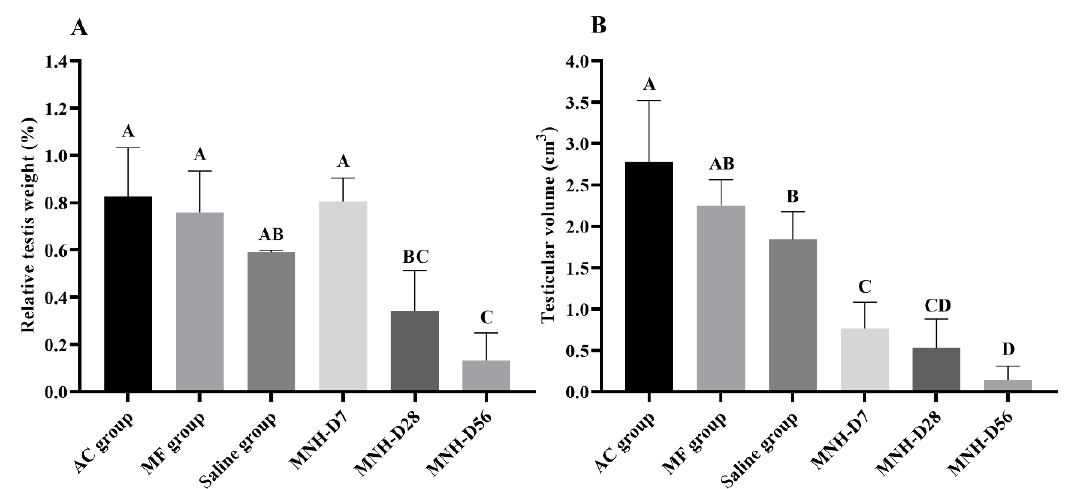
Figure 5. ( A ) Mean ( ± SD) relative testis weight (%) and ( B ) Mean ( ± SD) testicular volume (cm 3 ) for each experimental group on the day of euthanasia. (ABC—different letters indicate significant difference, p < 0.05.) AC Group animal testicles were exposed to the external AC magnetic field only. MF Group animals received an intratesticular injection of the magnetic fluid only. Saline Group animals received an intratesticular injection of sterile saline solution. MNH Group animals received an intratesticular injection of the magnetic fluid and had their testicles exposed to the external AC magnetic field.